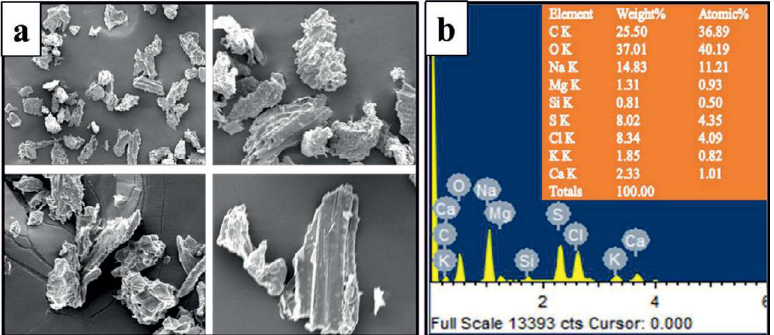
Fig. 5. (a) Irregular shape of the bio occulant; (b) SEM-EDAX spectra depicting the presence of C, K, O, Na, Ca, Mg, and Cl in the bio occulant.